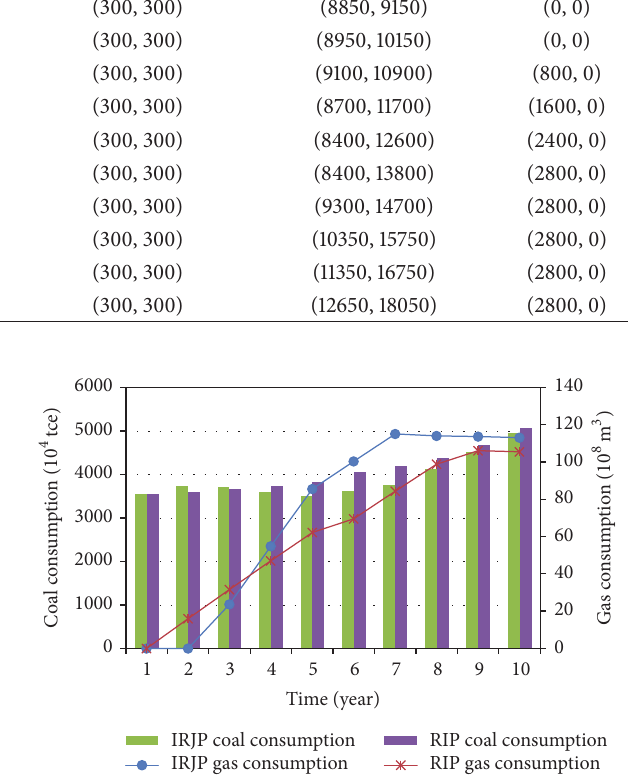
Figure 2: Fuel consumption comparison in IRJP mode and RIP